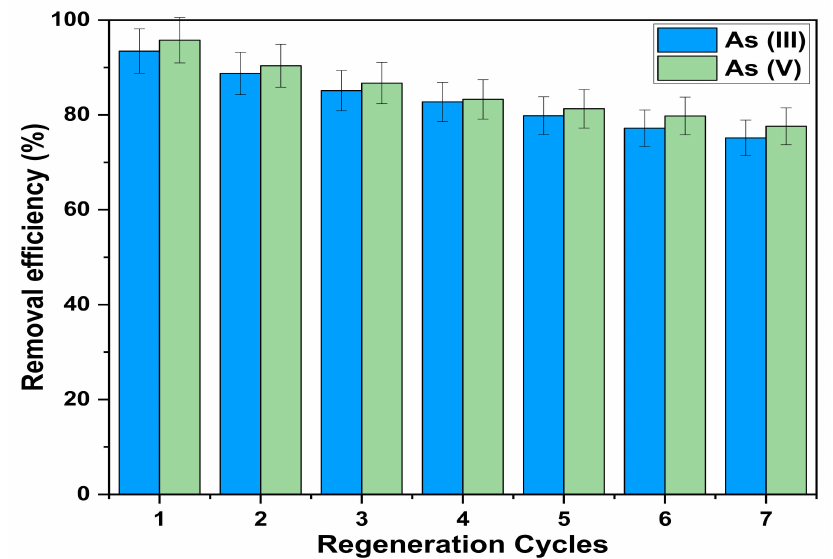
Figure 13. Regeneration cycles of As(III),